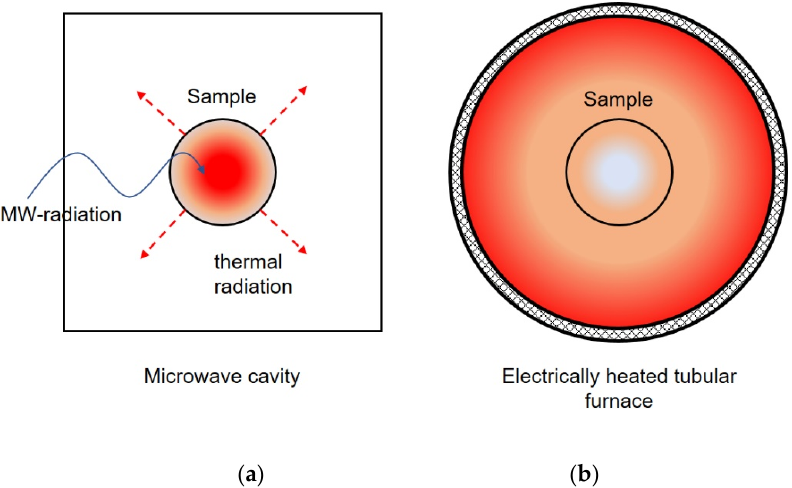
Figure 1. Schematic representation of different types of thermal gradients resulting from MW- heating ( a ) and conductive heating ( b ).